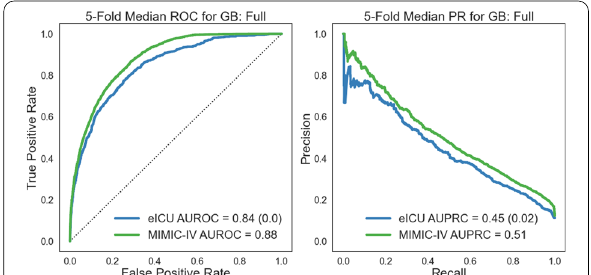
Figure 1. 5-Fold Median Performance Curves for Full Population.